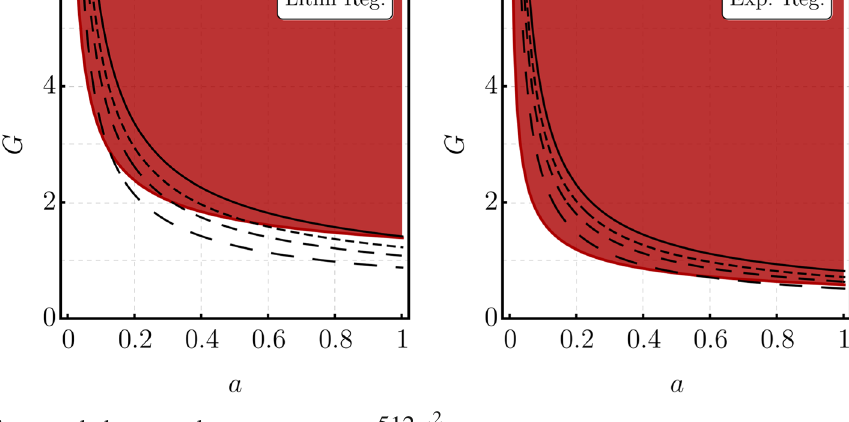
G ∗ ( a ) . Different lines correspond to different number ( N A ) Abelian-gauge fields added to our truncation. From top to bottom: N A = 0 , 1 , 2 ,